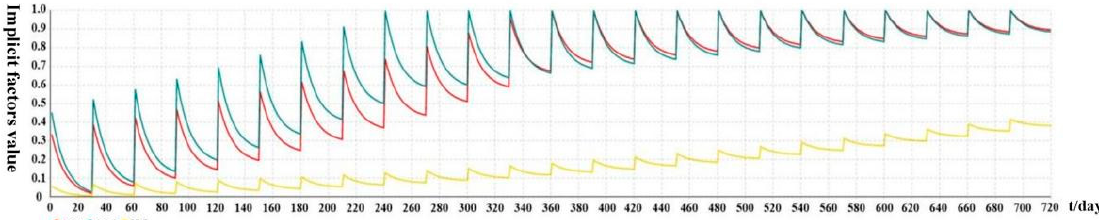
Figure 5. Variation trend of each implicit attitude over time under active intervention.